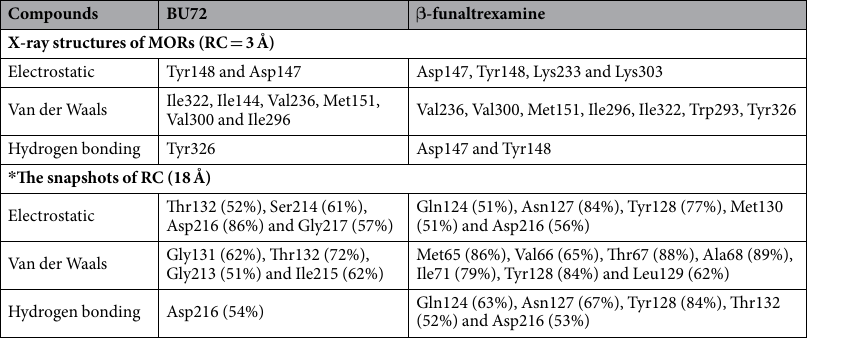
Compounds BU72 β -funaltrexamine